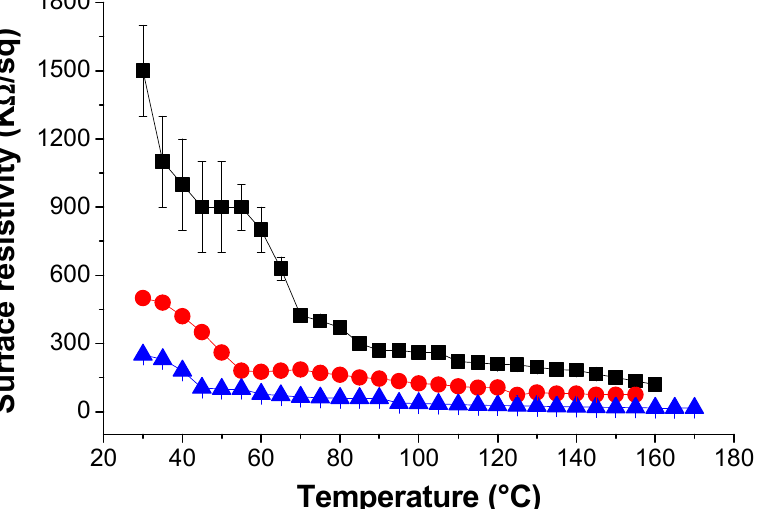
Figure 8. Surface resistivity of the nanocomposite composed by PK30-Gly-Gly and lrGO at different temperatures and filler concentration. ( ) 6 wt. %. ( ) 7 wt. %. ( ▲ ) 8 wt. %. Sample thickness of 1.05 mm.